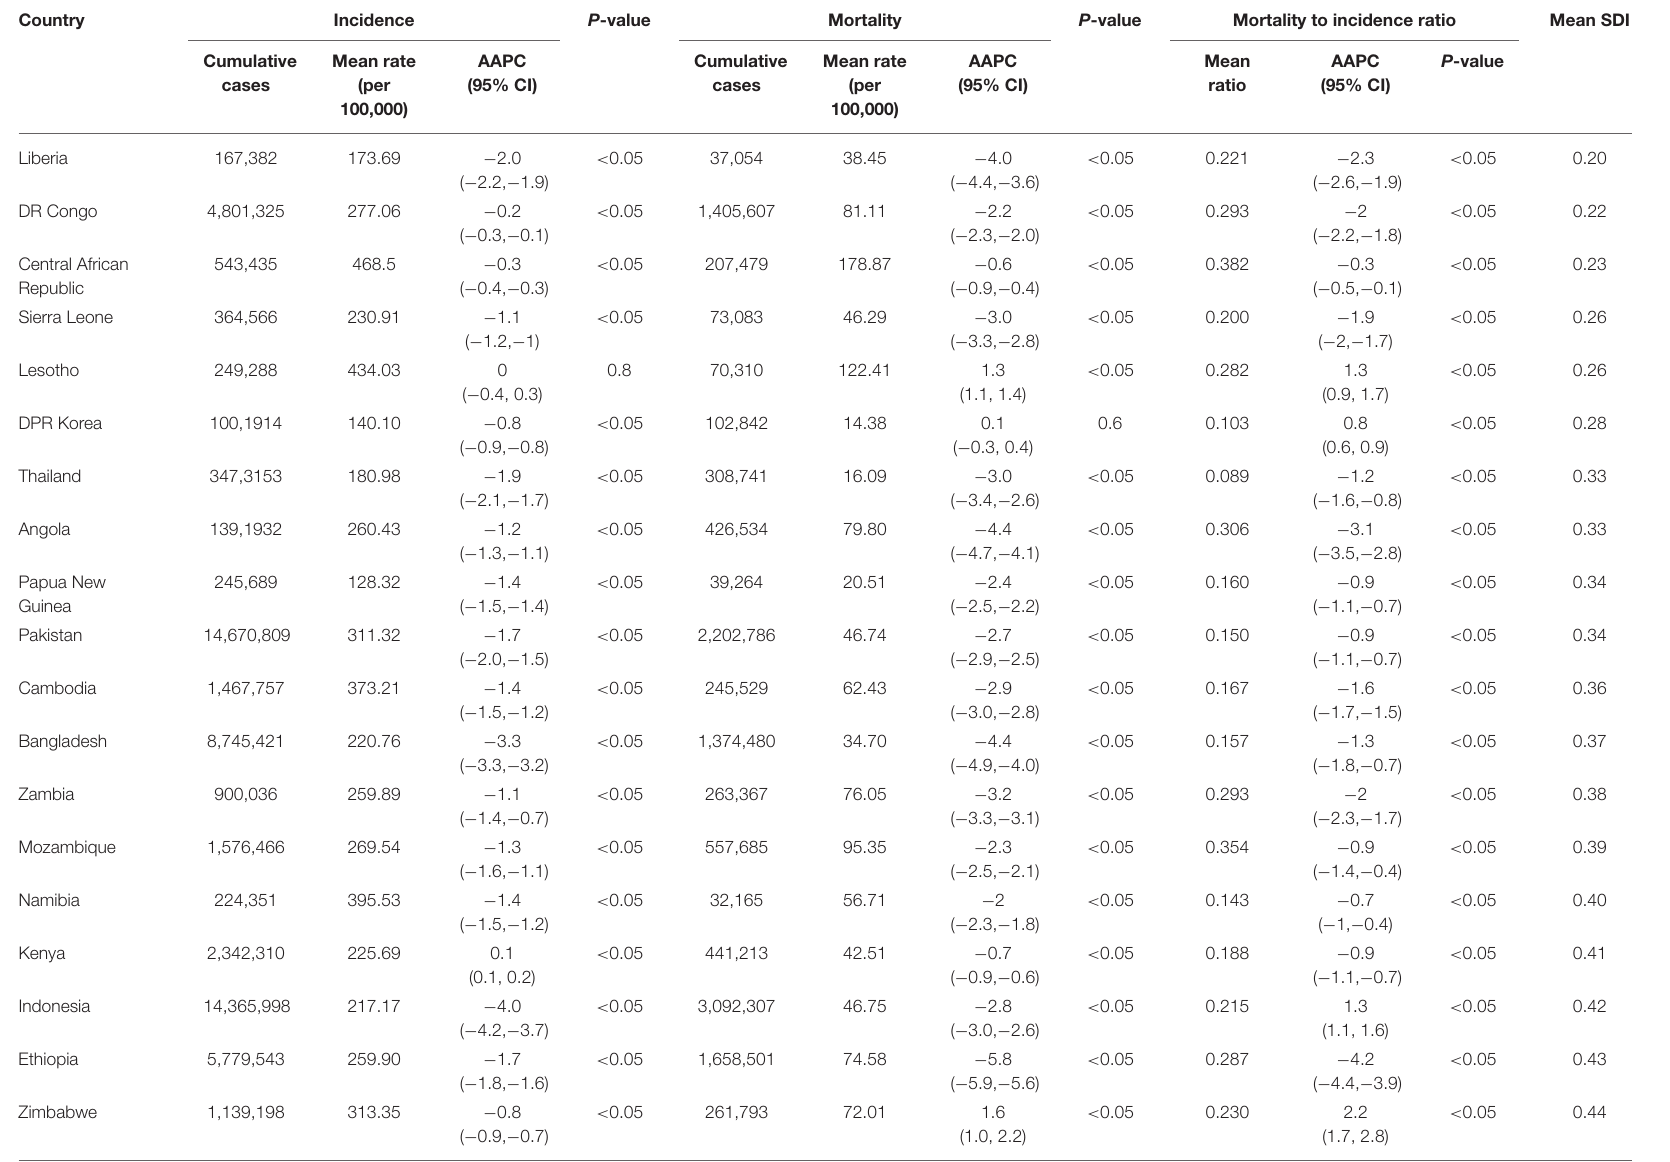
TABLE 1 | Incidence, mortality, and MI ratio trends of tuberculosis (TB) in 30 HBCs, 1990–2019.